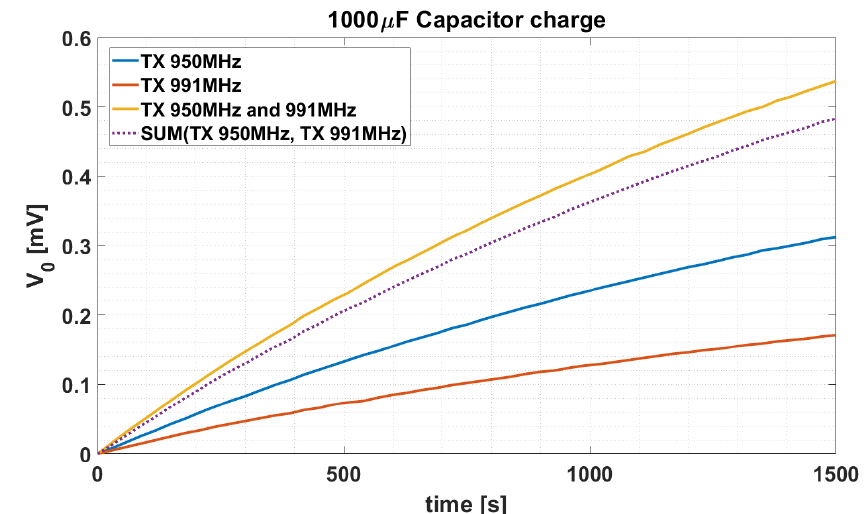
Figure 11. Measurements of the charging time for all combinations of the transmitted